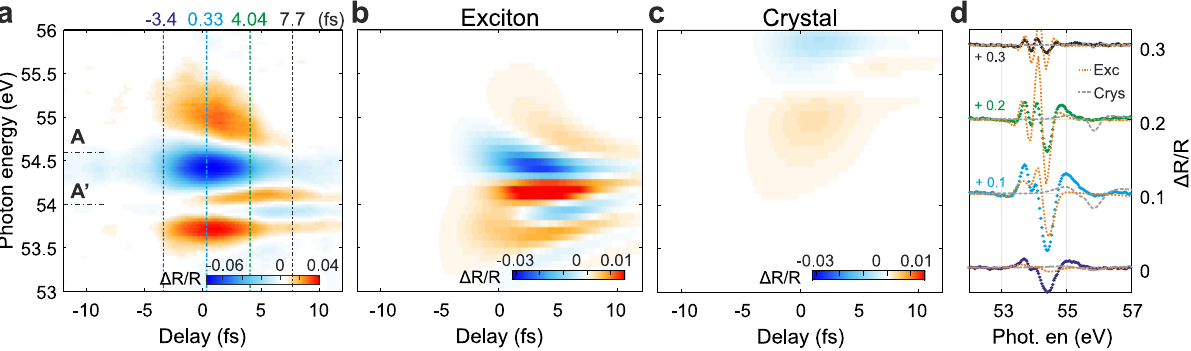
Fig. 2 Real-time observation of femtosecond core-exciton dynamics. a Slow component of the experimental Δ R / R reported in Fig. 1d. b , c Calculated slow component of Δ R / R considering solely the two excitonic states or only the crystal CB, respectively. d Measured (dots) and calculated (orange dotted and grey dashed curves) Δ R / R pro fi les for four representative delays marked by the dash-dotted vertical lines in ( a